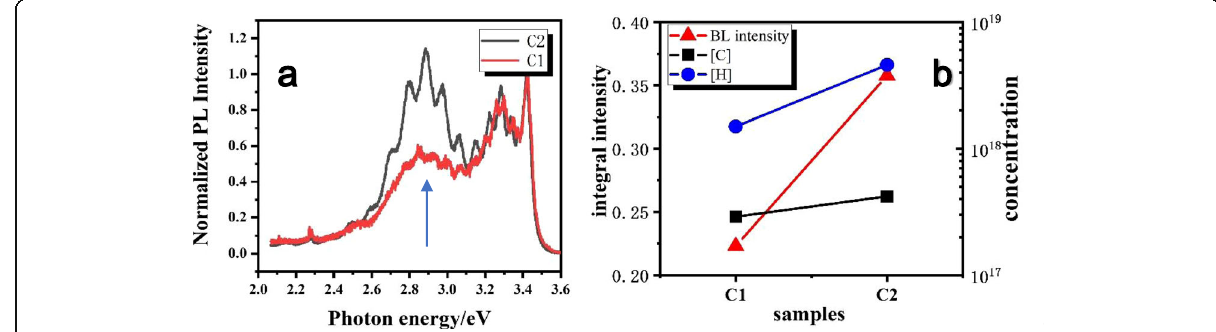
Fig. 3 a The normalized PL intensity of samples C1 and C2. b Integral PL intensity and C and H concentration for samples C1 and